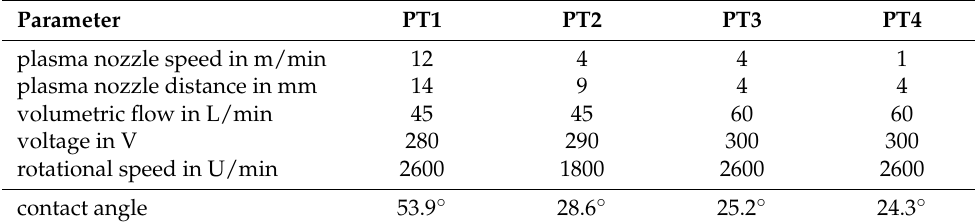
Table 5. Plasma treatment (PT) parameter combination for sample